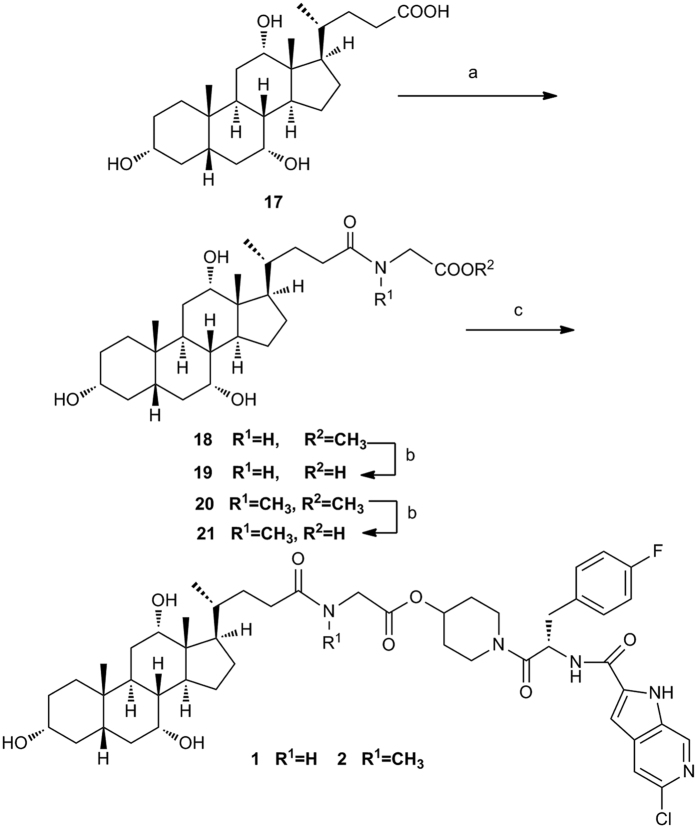
Synthesis of conjugates 1–2a.Reagents and conditions: (a) R1NHCHCOOMe·HCl, HATU, DIPEA, THF, 30 °C, 63% yield for 18, 48.6% yield for 20; (b) LiOH·H2O, THF/H2O, rt, 76% yield for 19, 79% yield for 21; (c) PSN-357, DCC, DMAP, DMF, rt, 10.9% yield for 1, 21% yield for 2.